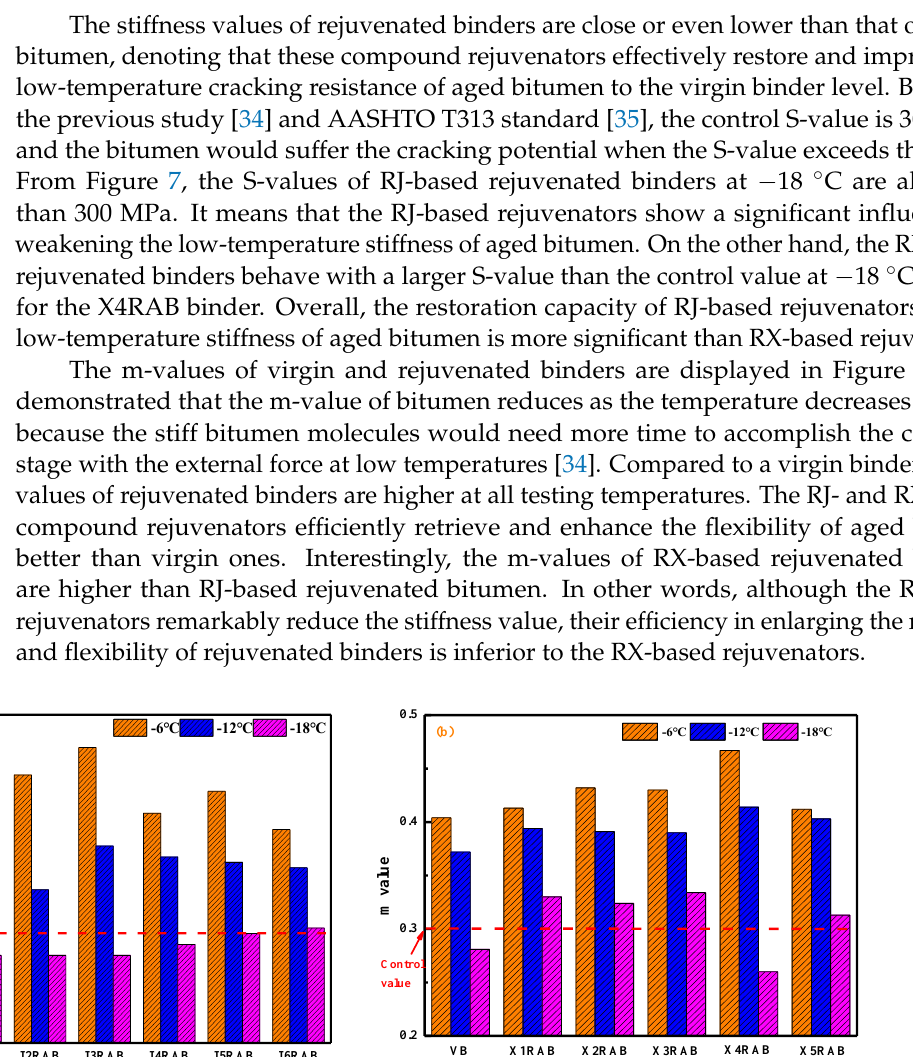
Figure 8. The m-value of rejuvenated bitumen at different temperatures.